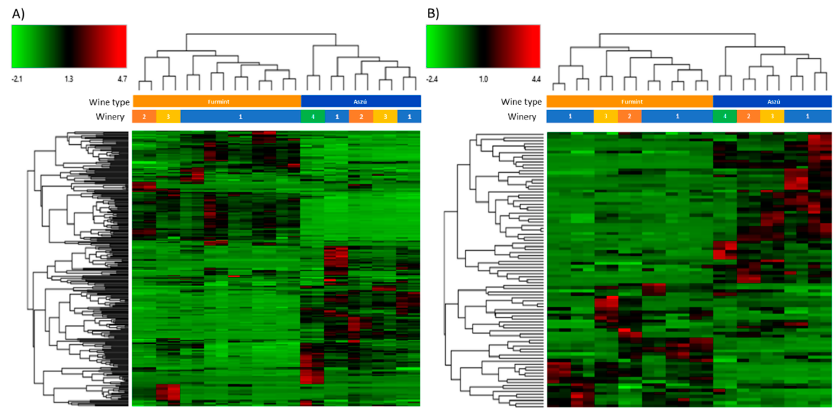
Figure 1. Principal component analysis of “aszú” and “furmint” wine samples analyzed in positive panel ( A ) and negative panel ( B ) polarity mode. The “x” axis shows PC1 while the “y” axis shows PC2. The orange dots represent the “furmint” samples while the blue dots represent the “aszú” samples. The wineries are also indicated with numbering.